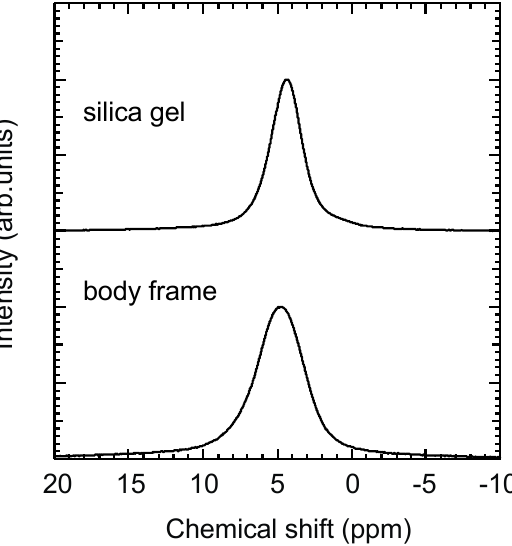
Figure 4. 1 H NMR spectra for sponge body frame and silica gel.